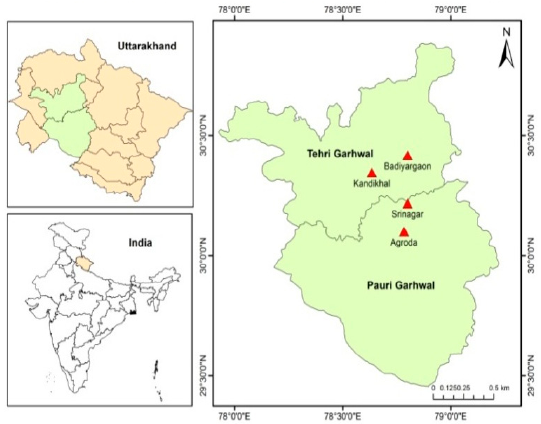
Figure 1. Map of the study area location. Table 1. Geographical description of C. australis foliage collection sites.